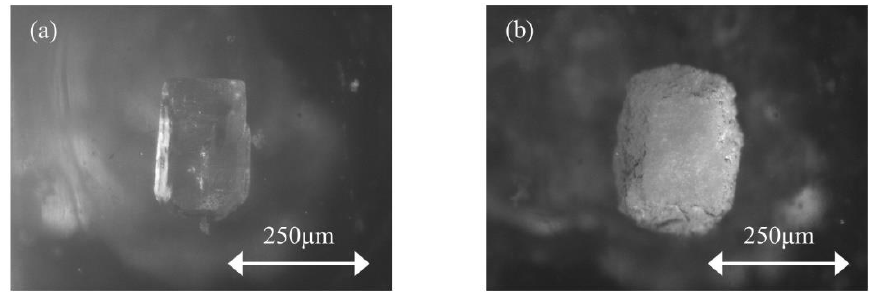
Fig. 5. (a) Sugar crystal before impact at 650m/s (b) Sugar crystal after impact at